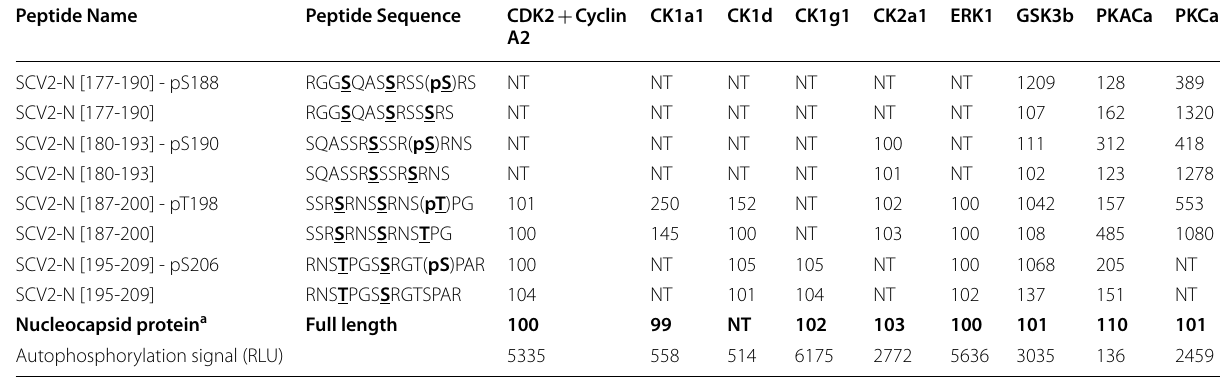
Predicted GSK3 phosphorylation sites are bolded and underlined NT not tested a Relative phosphorylation is shown in comparison to the signal recorded as Relative Light Units (RLU) with each protein kinase incubated in the absence of added peptide substrate with ATP alone (set to 100). Values are averages from duplicate measurements Table 2 In vitro phosphorylation of synthetic peptides modeled after SARS‑CoV‑2 nucleocapsid protein phosphorylation sites by recombinant protein kinase C‑alpha and glycogen synthase kinase‑beta using the ADP‑Glo method